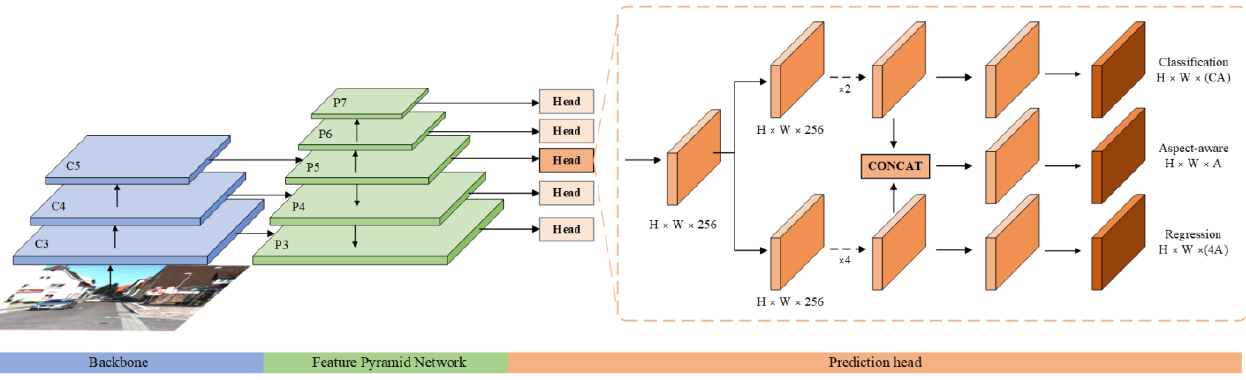
Figure 3. The overall structure of AspectNet. The supervised model learns the categories, positions, and aspect ratios of objects. The feature map of the aspect-aware head consists of the classification and regression branches.